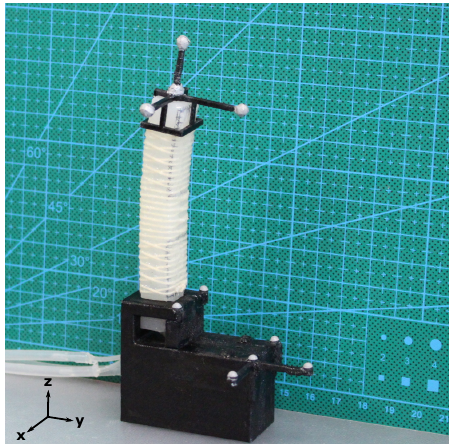
Figure 4. Motion capture marker setup for trajectory measurements. The two center markers on the tip of the actuator formed its tip vector. Other markers were used as a